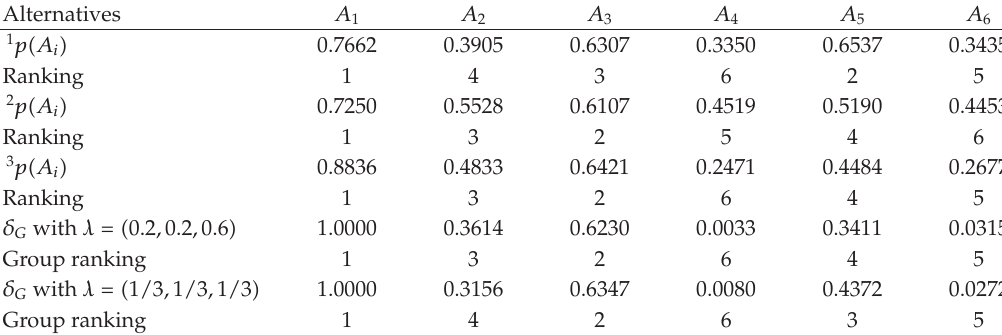
Table 14: Application of the TOPSIS to rank the